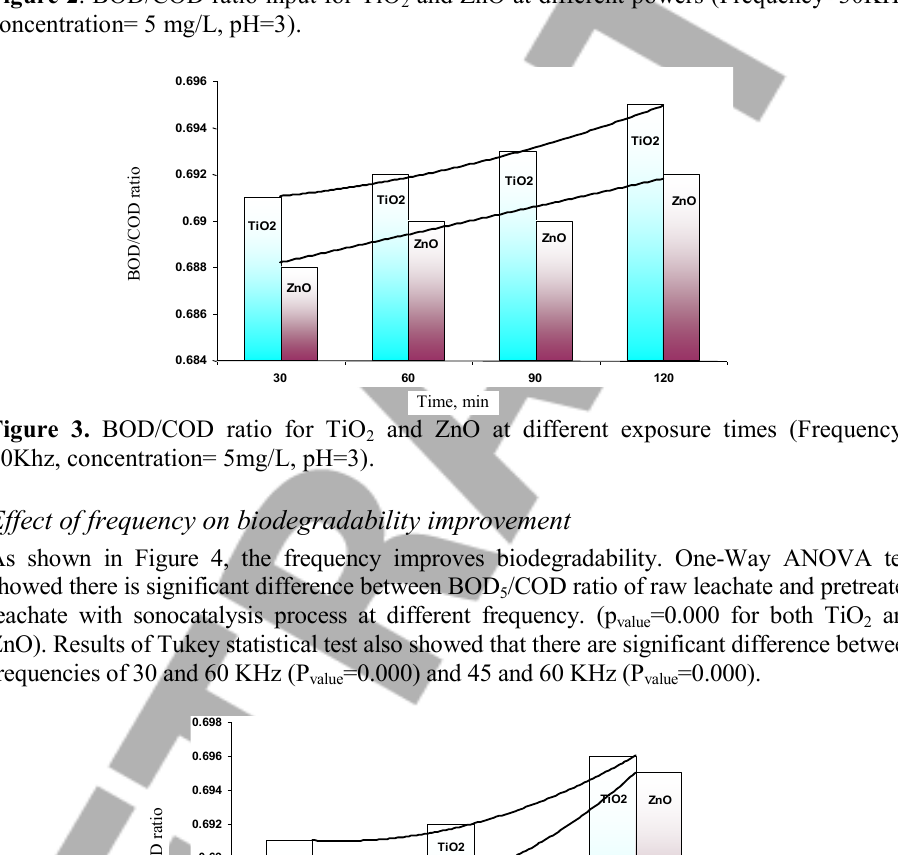
and ZnO at different powers (Frequency=30KHz, 2